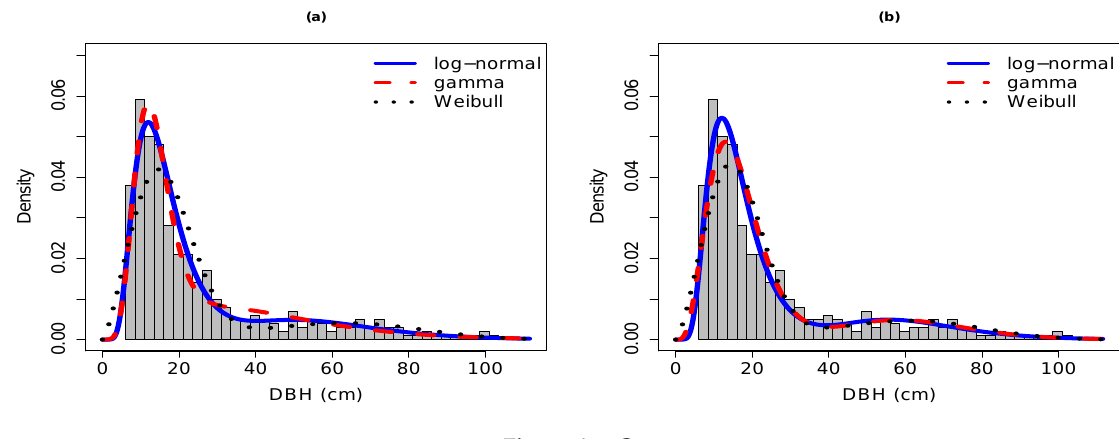
Figure A2. Histograms of DBH data in sample 2. ( a ): 2-component mixture models fitted to grouped data corresponding to classes of width 2.5 cm, ( b ): 2-component mixture models fitted to ungrouped data, ( c ): 2-component mixture models fitted to grouped data corresponding to classes of width 5 cm, ( d ): 2-component mixture models fitted to ungrouped data, ( e ): 3-component mixture models fitted to grouped data corresponding to classes of width 2.5 cm, ( f ): 3-component mixture models fitted to ungrouped data, ( g ): 3-component mixture models fitted to grouped data corresponding to classes of width 5 cm, ( h ): 3-component mixture models fitted to ungrouped data. Superimposed in each subfigure are estimated pdf of the mixture of Weibull (solid line), gamma (dashed line), and log-normal (dotted line)